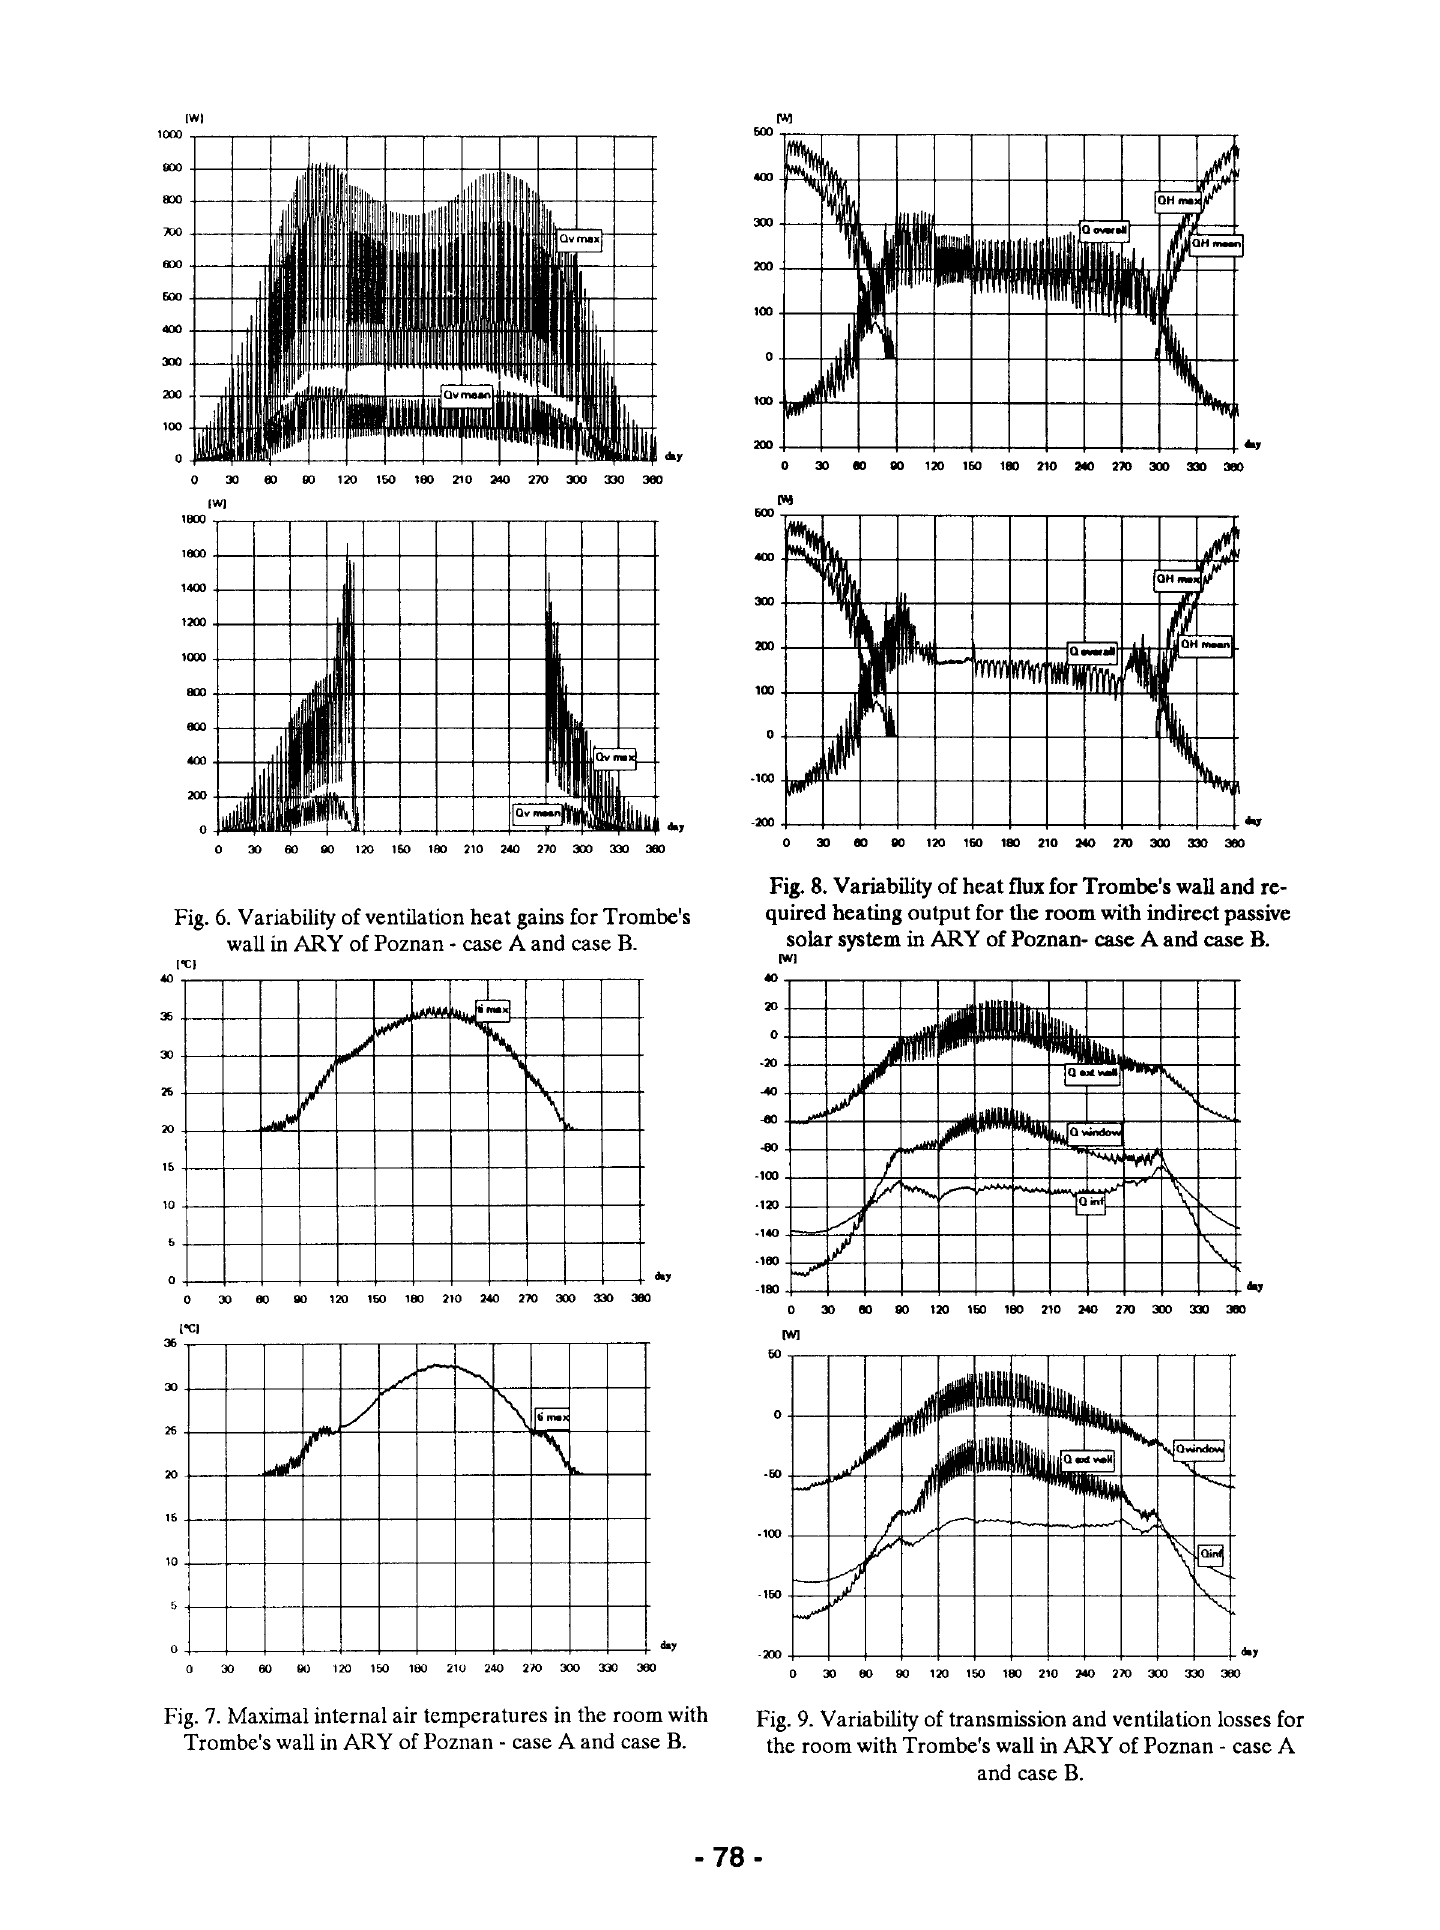
Fig. 9. Variability of transmission and ventilation losses for the room with Trombe's wall in ARY of Poznan- case A and case